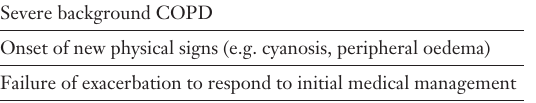
Indications for hospital assessment or admission for acute exacerbation of